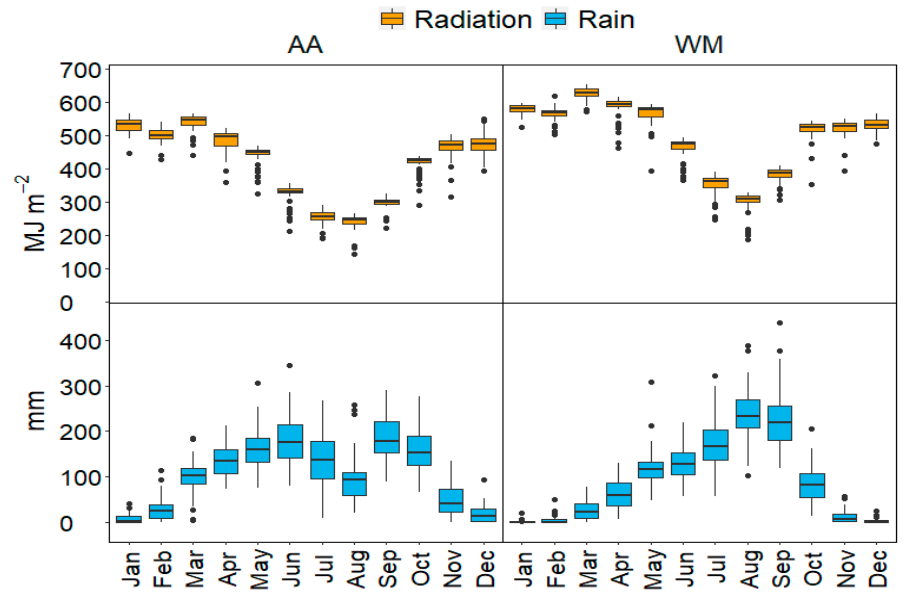
Figure 1. Location of the study areas in Ghana.